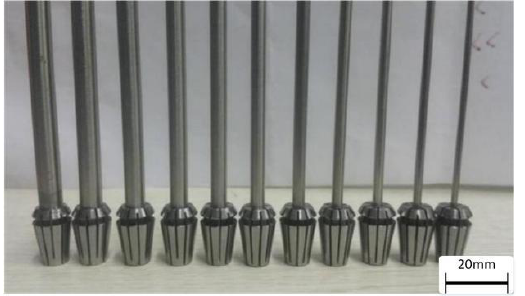
Figure 7. The different diameters of the rotating rods in the experiment.